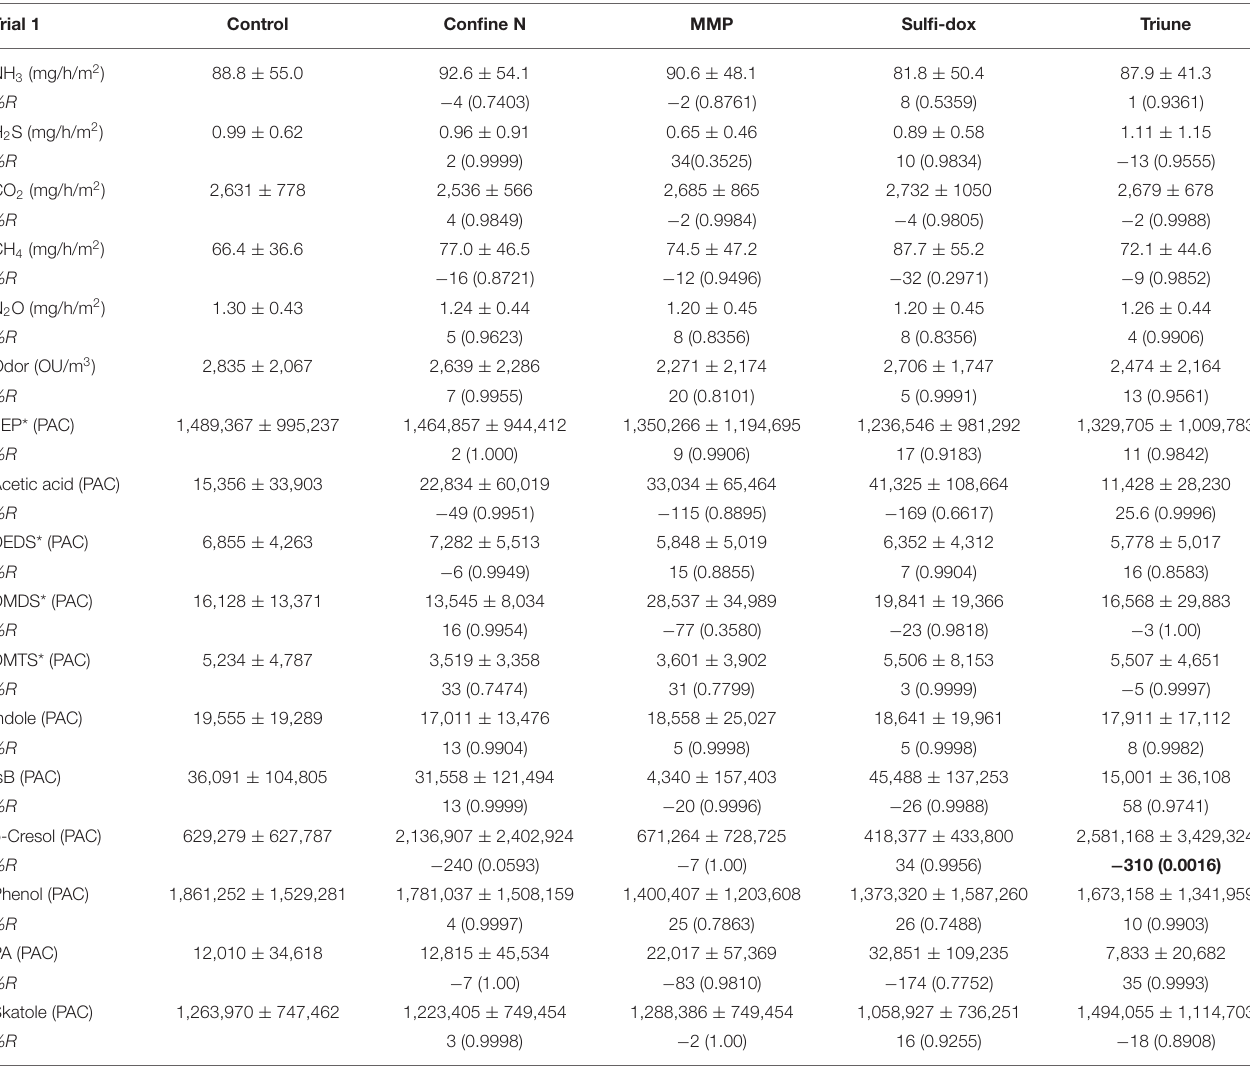
TABLE 2 | Trial 1-comparison of averaged gaseous emissions (flux or arbitrary units for VOCs) and percent reductions ( %R ) from three types of manure sources (farms) with their standard deviations. Trial